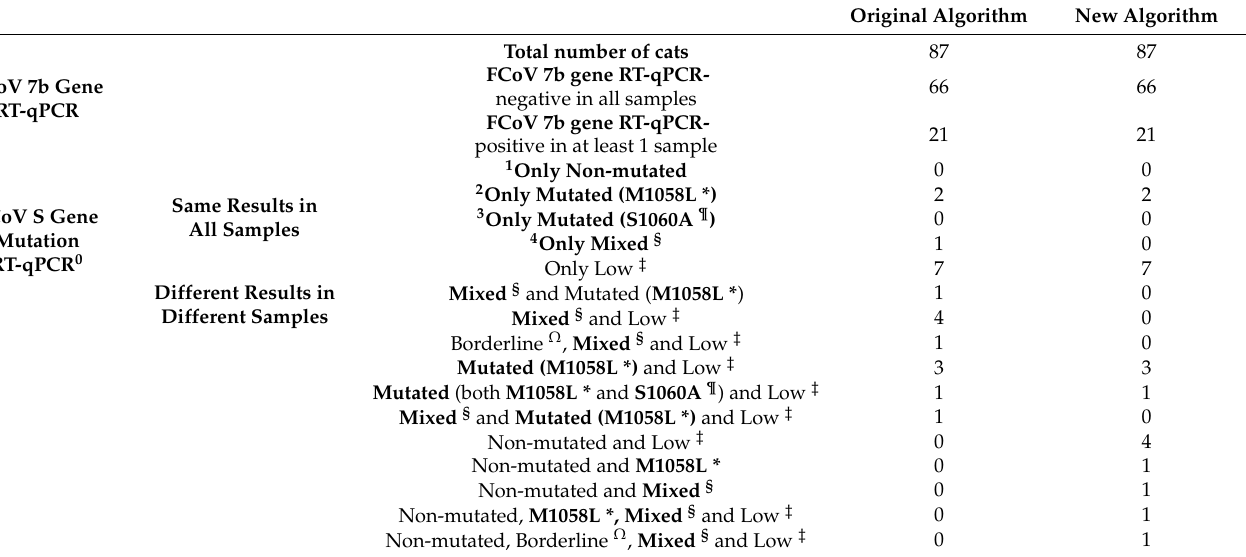
Table 1. Results of the commercial real-time feline coronavirus (FCoV) 7b gene reverse transcription polymerase chain reaction (RT-qPCR) and spike (S) gene mutation RT-qPCR following the original algorithm, and the new algorithm for interpretation of the results in the 87